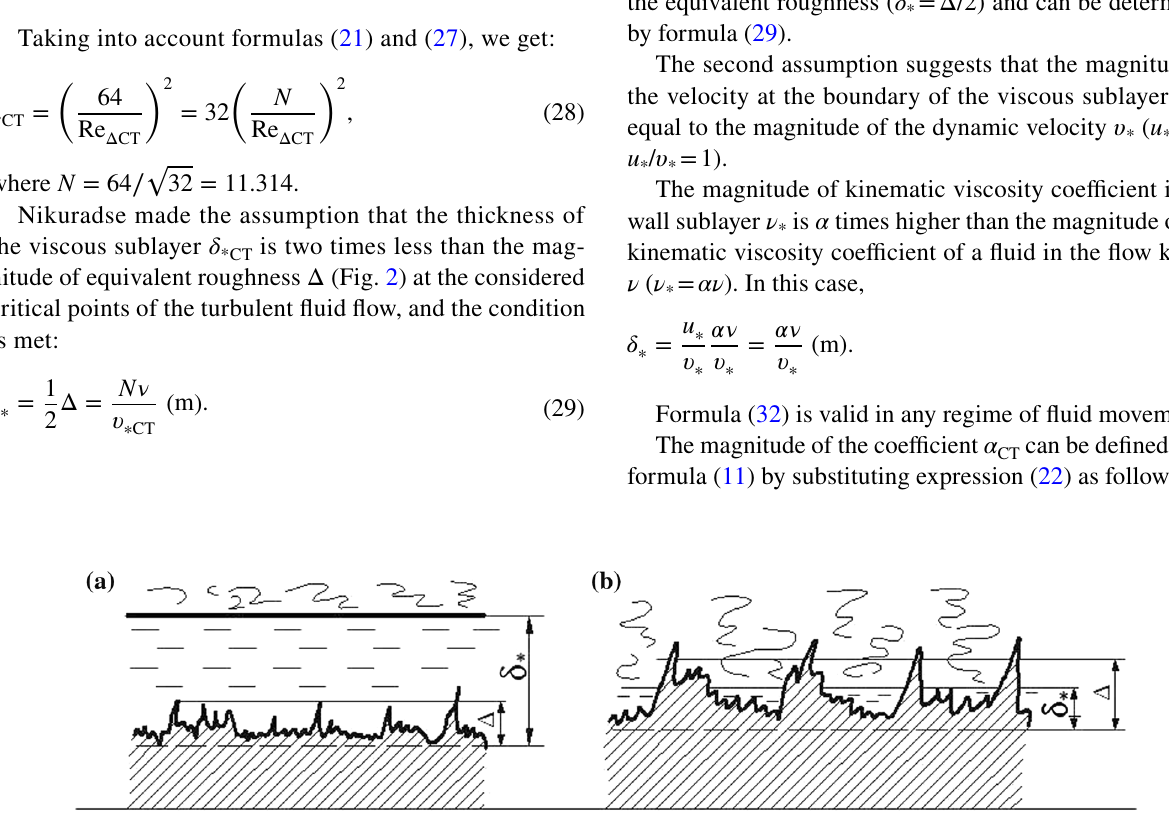
Fig. 2 Scheme for a viscous wall sublayer in hydraulically smooth pipes ( a ), and rough pipes at υ = υ Nikuradse ( b